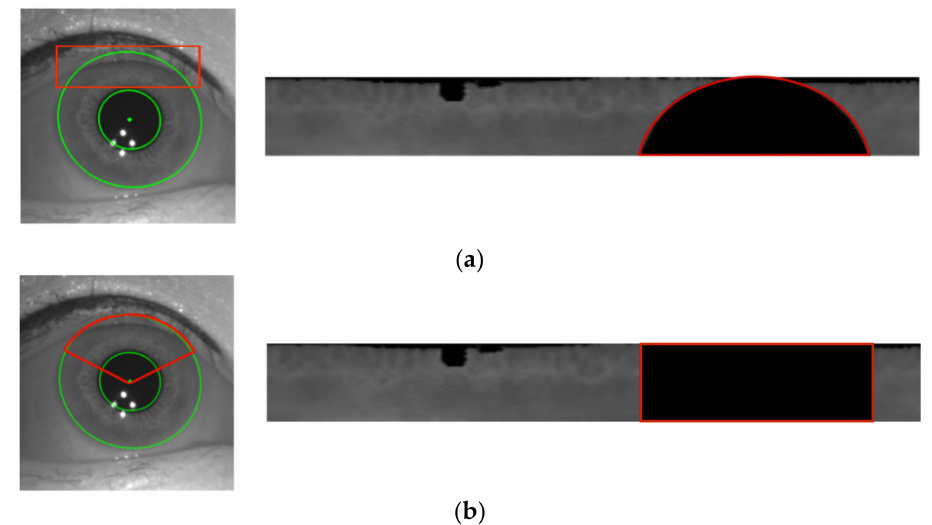
Figure 7. ( a ) Rectangular mask used in present work; ( b ) a fan-shaped mask.